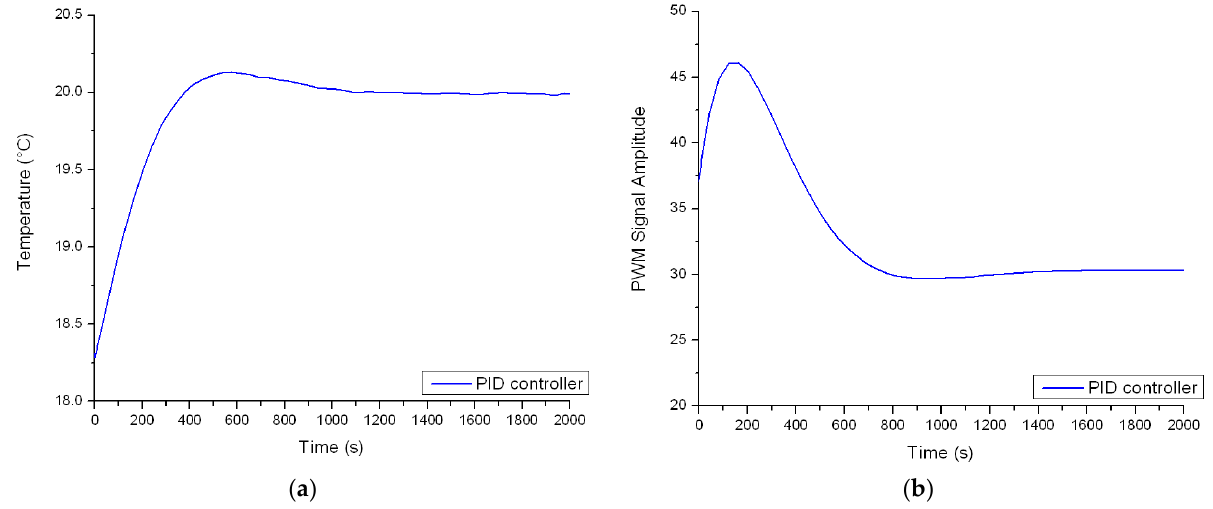
Figure 14. ( a ) Time vs. temperature graph and ( b ) shape of actuating signal.